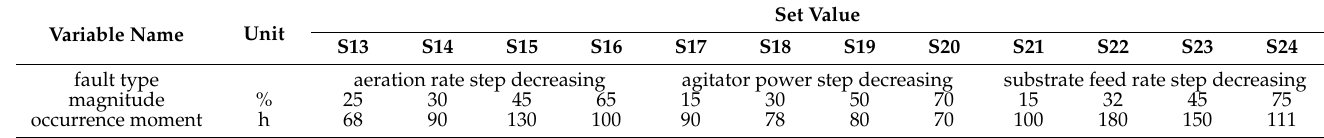
Table 3. The details of test samples 13~24.